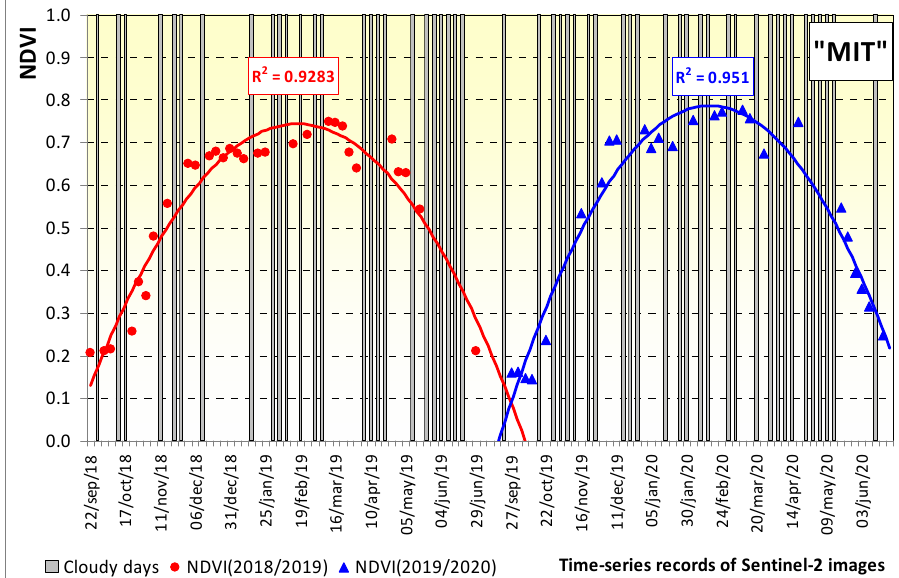
Figure 11. NDVI time-series records obtained in 2018/2019 and 2019/2020 in “MIT” field.